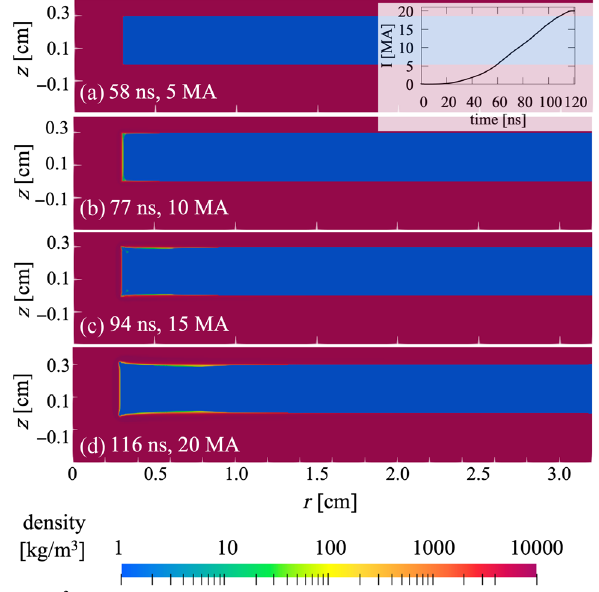
FIG. 11. The electrode density contours from MHD at 4 times during the pulse, which shown for reference in the top right inset. The times and corresponding currents are noted for (a) 58 ns = 5